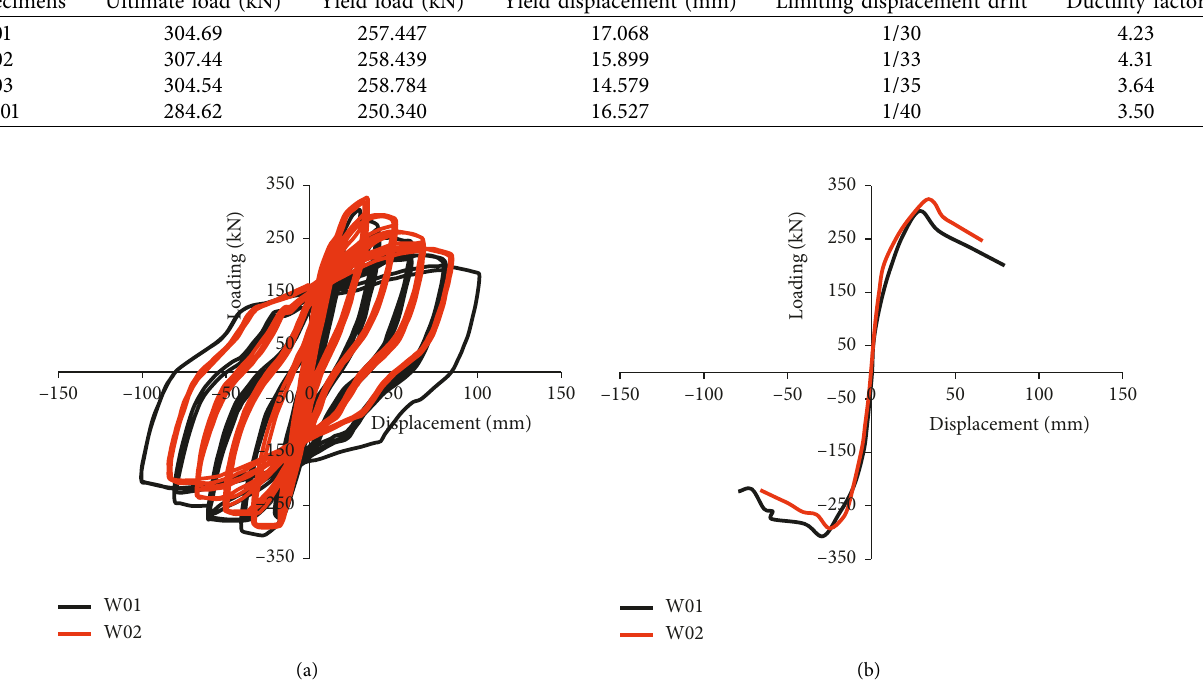
Figure 7: Comparison of hysteresis curves and skeleton curves of specimens with different thicknesses of outsourcing steel pipes. (a) Comparison of hysteresis curves between W01 and W02. (b) Comparison of skeleton curves between W01 and W02.